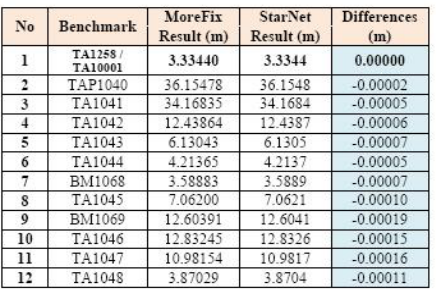
Table 1: The results of BMs height computed by MoreFix using Pulau Lakei as datum (Adjustment case